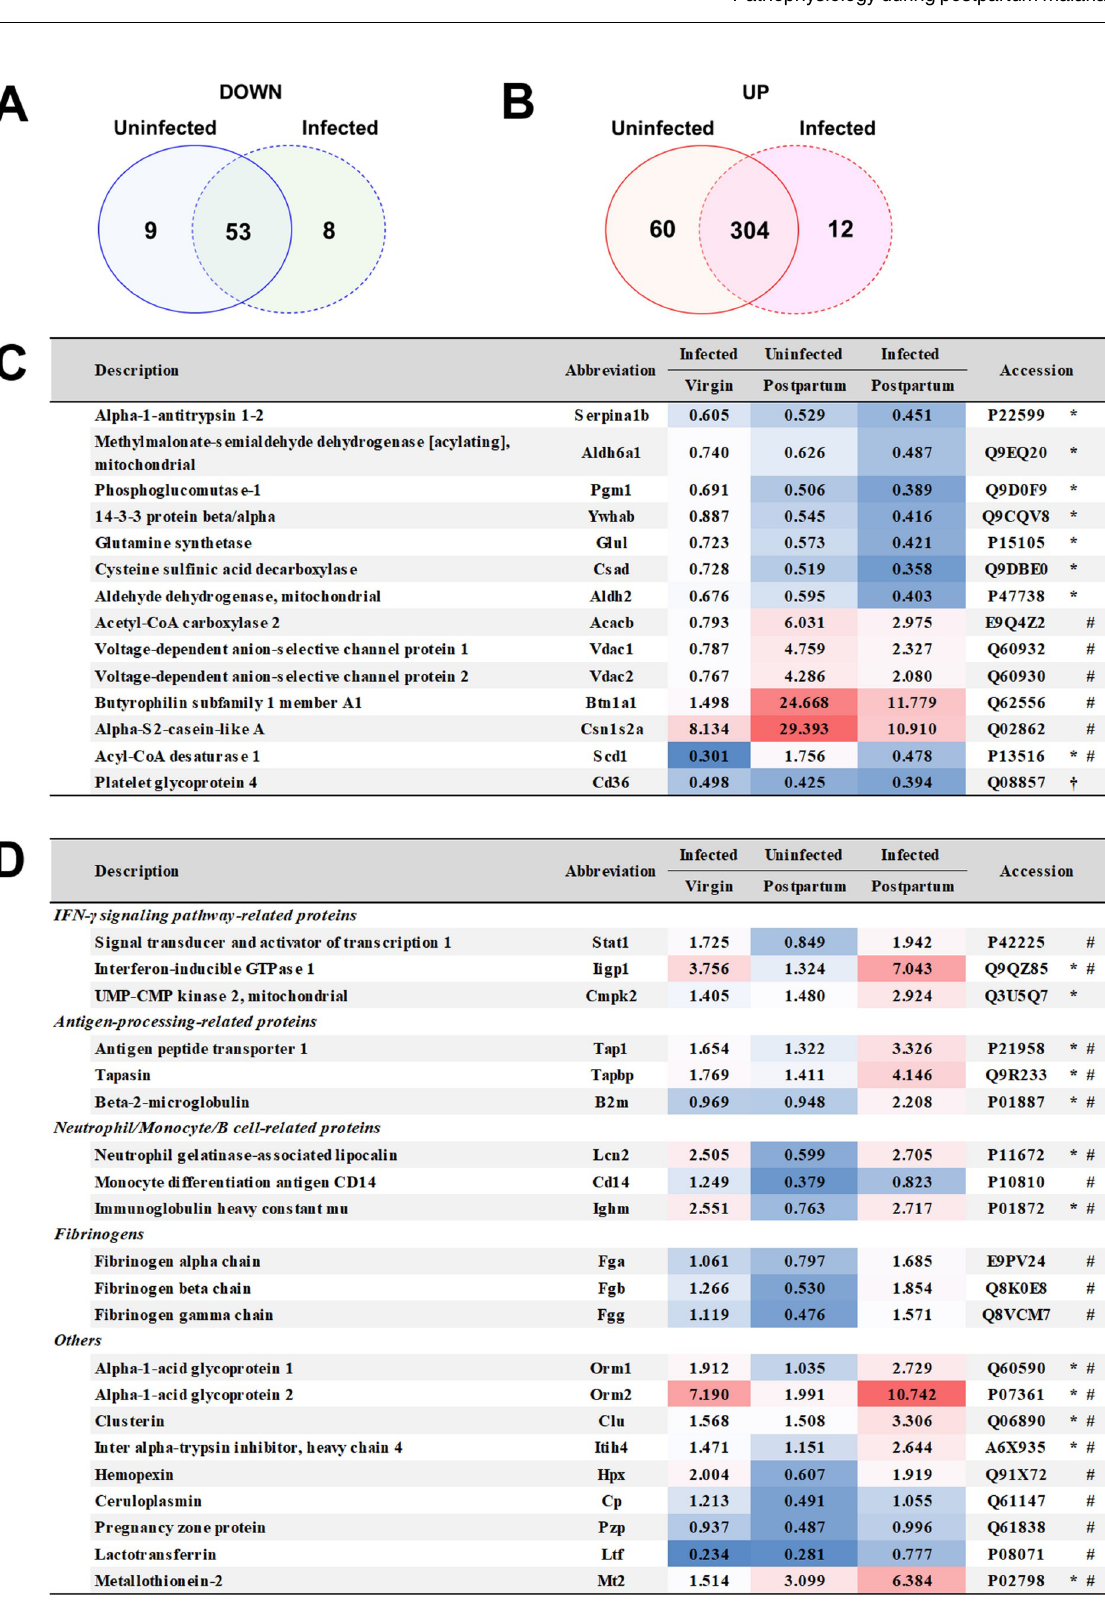
Fig 3. Effects of malaria on the proteome in mammary gland tissue of postpartum mice. (A and B) Venn diagram of protein levels in mammary gland tissue of uninfected and infected postpartum mice that changed 0.5-fold (A) or 2-fold (B) compared with uninfected